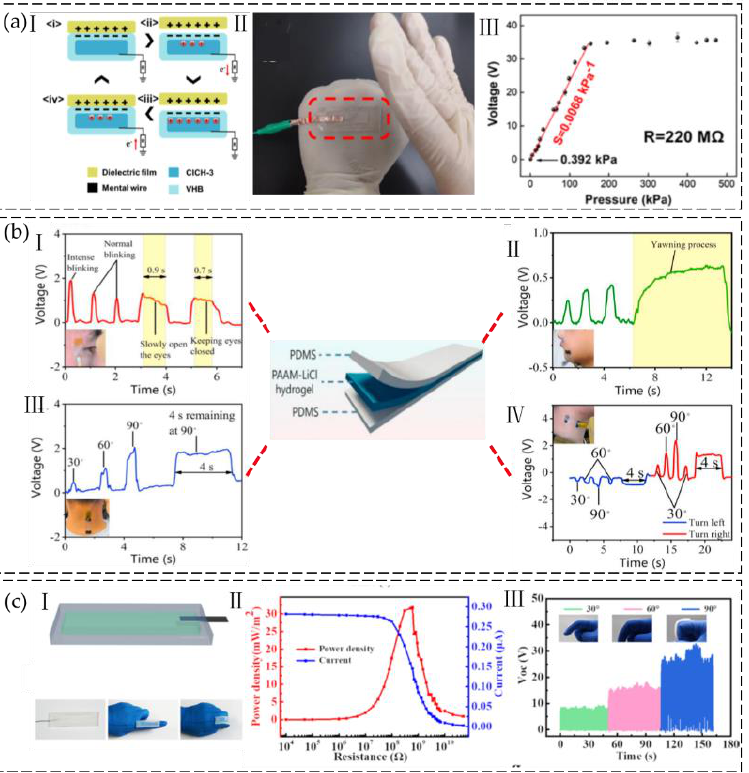
Figure 5. ( a ) Cellulose hydrogel for flexible sensor. Ⅰ . Schematic working mechanism of CNH TENG. Ⅱ . A transparent hydrogel TENG tapped by fingers. Ⅲ . Various peak amplitudes of voltage across the resistor (220 M Ω ) with different pressures applied. (Reprinted with permission from [63].) ( b ) Use of a hydrogel-based TENG for driving fatigue monitoring. I. Eye-closure movement detection. II. Yawning detection. III. Head-turning movement detection. IV. Vertical bending angle detection. (Reprinted with permission from [65]). ( c ) Self-Powered Smart Arm Training Band Sensor. I. Schematic diagram of the SA − Zn hydrogel TENG and the photographs of the SH-TENG in its original and foldable state. II. Output Performance of the SH-TENG. III. The voltage outputs of the SH-TENG under bending of the finger. (Reprinted with permission from [66].)